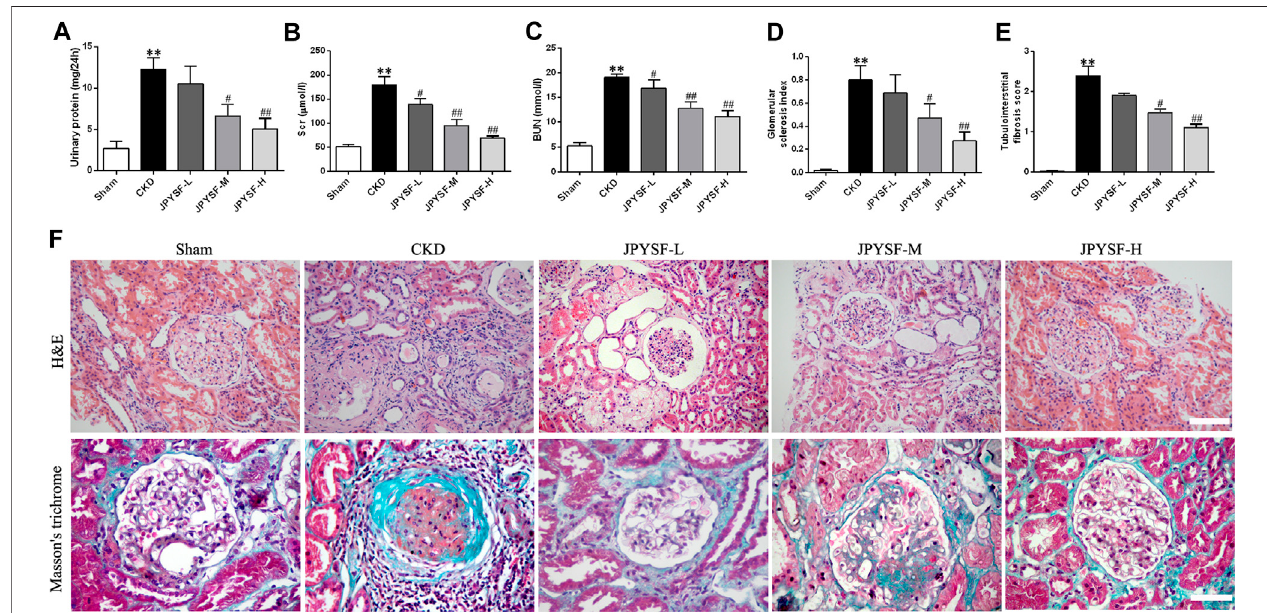
FIGURE 1 | JPYS formula improves renal function and alleviates renal histopathology and ultrastructural pathology of the kidneys from CKD rats. (A) 24h urinary proteinexcretion. (B) Serumcreatinine(SCr). (C) Bloodureanitrogen(BUN). (D) Glomerularsclerosisindex. (E) Tubulointerstital fi brosisscore. (F) Hematoxylinandeosin (HE × 200, scale bar (cid:2) 100 μ m) and Masson ’ s trichrome stains ( × 400, scale bar (cid:2) 50 μ m). All data are expressed as means ± SEM. * p < 0.05, ** p < 0.01 vs. the sham group; # p < 0.05, ## p < 0.05 vs. CKD group.